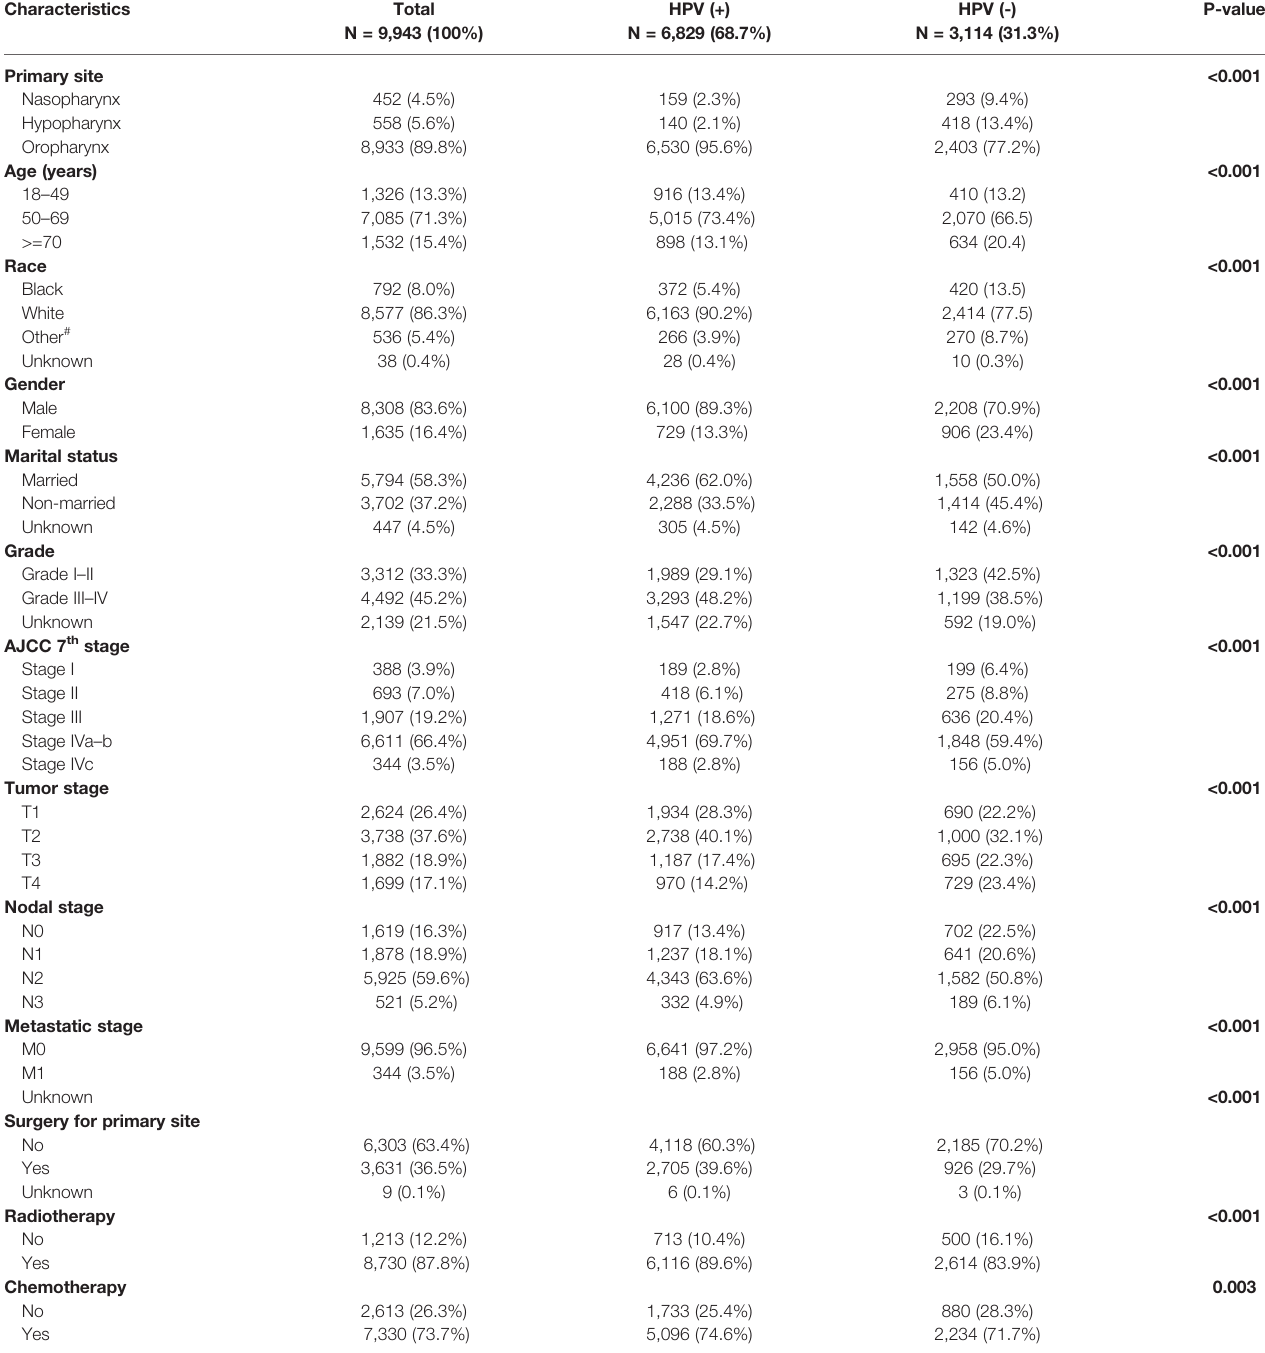
TABLE 1 | Clinical and demographic features of HNSCC population according to HPV